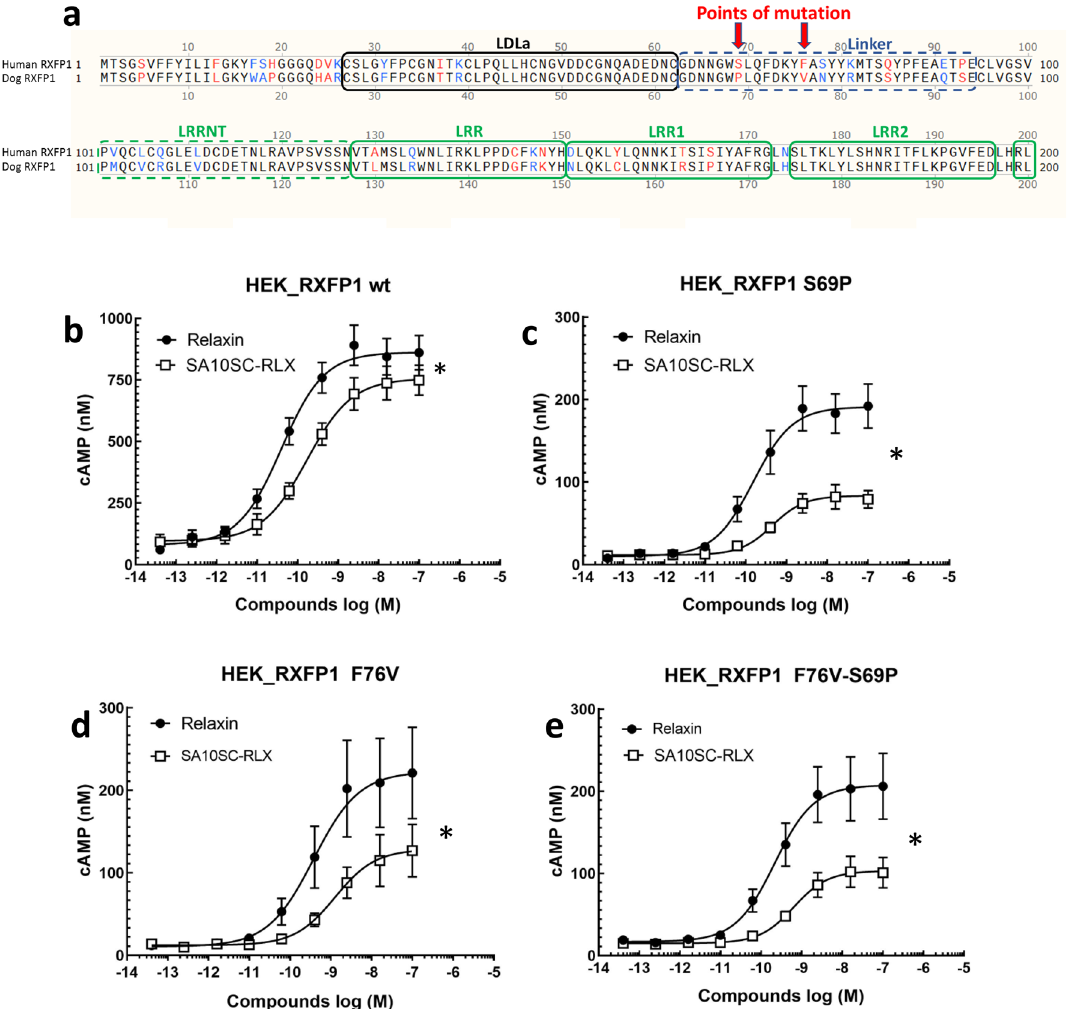
Figure 3. Role of linker domain in RXFP1 activation by SA10SC-RLX. Alignment of human RXFP1 (protein sequence NP_067647.2) with dog RXFP1 (sequence MW713050) across the first 200 amino acids of the N-terminus showing the LDLa and linker domains The arrows indicate the point mutations of interest (S69P and F76V) in the linker domain between the LDLa domain and the first LRR domain of the extracellular domain of RXFP1 ( a ). Concentration dependent effects of relaxin and SA10SC-RLX on cAMP production in HEK_RXFP1 cells (mean ± SEM, n = 4 experiments performed in duplicate) ( b ). Significantly decreased response of SA10SC-RLX compared to relaxin on cAMP production in HEK_RXFP1 cells mutated in the linker in position S69P ( c ), F76V RXFP1 ( d ) or F76V-S69P ( e ) (mean ± SEM, n = 4 experiments performed in duplicate). For Emax comparison between relaxin and SA10SC-RLX, normality hypothesis was confirmed for each group and a paired T test was performed. In the absence of normality hypothesis, a Wilcoxon test was performed (* P <